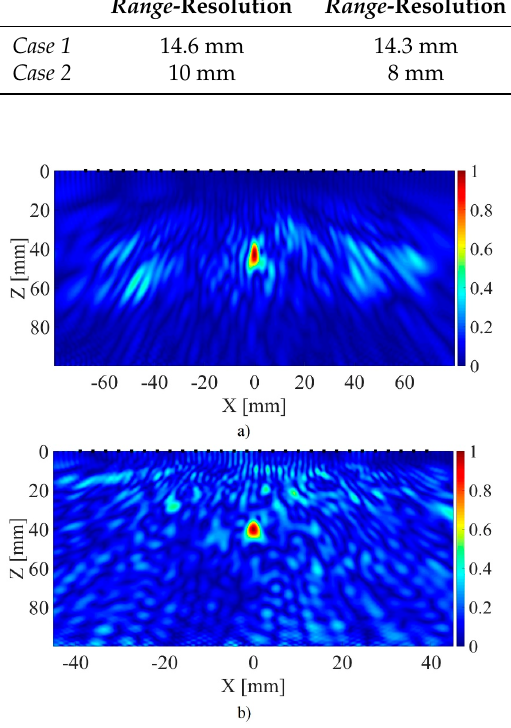
Table 1. Spatial Resolution Measured on the Simulated Point Spread Functions (PSFs) and Theoretical Values @ 33.25 GHz.